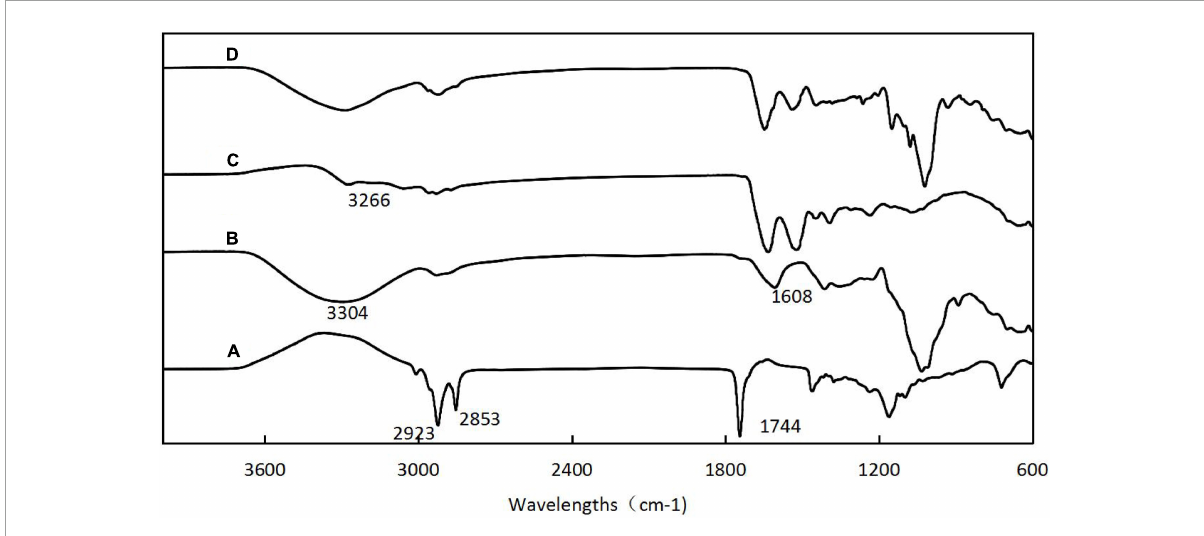
FIGURE4 Fourier transform infrared spectroscopy (FT-IR) spectra of H. rhamnoides seed oil (A); SPS (B); SIP (C); H. rhamnoides seed oil microcapsules